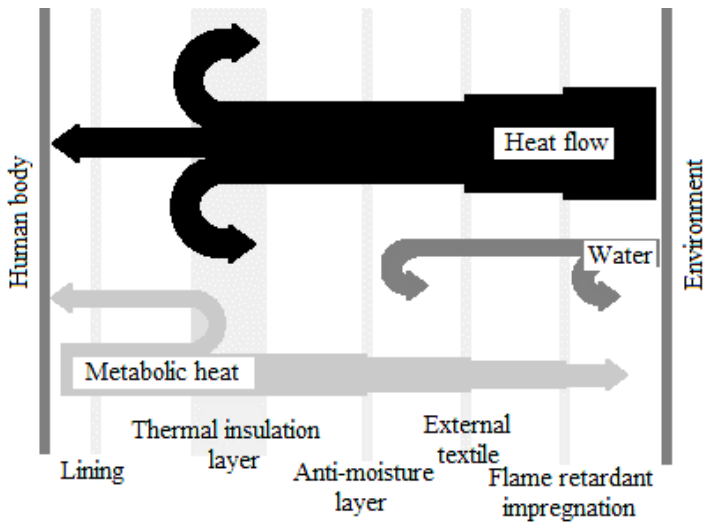
Figure 1. Heat flow during the thermal impact on the rescuer in special firefighter clothing.